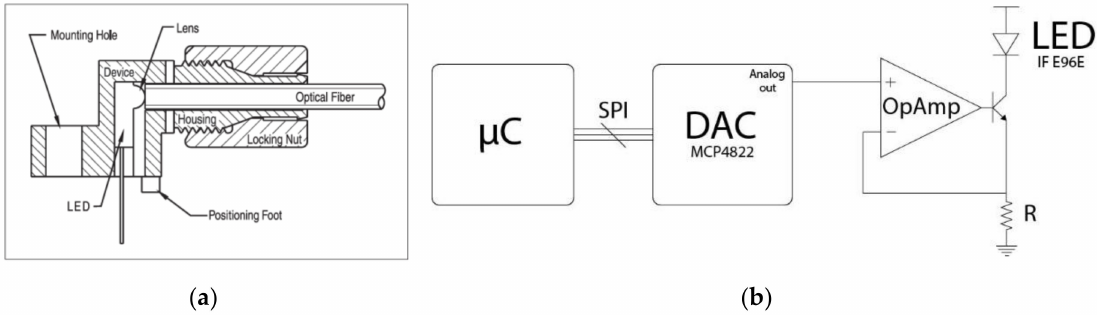
Figure 4. ( a ) Cross section of the LED used to inject light in the plastic fiber; and ( b ) schematic representation of the current driver circuit.